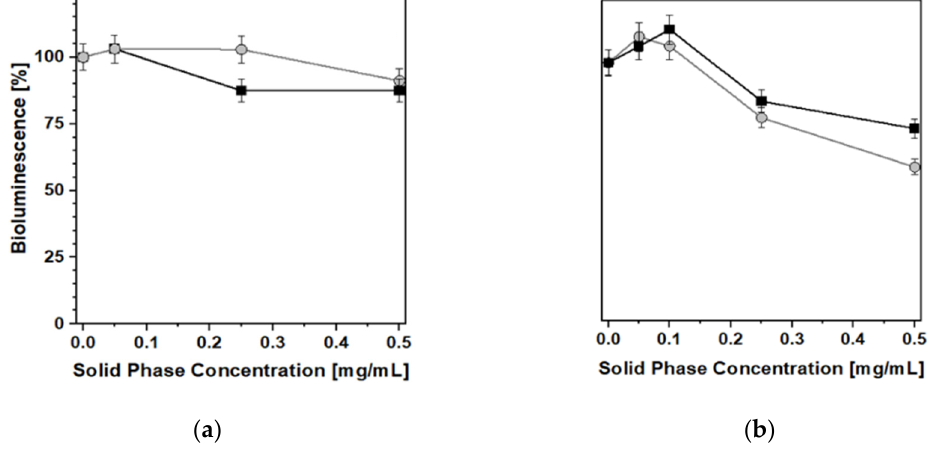
Figure 8. Acute effect of ● PB_Syn and ■ PB_Com samples on Photobacterium leiognathi Sh1 ( a ) and Figure 8. Acute e ff ect of • PB_Syn and (cid:4) PB_Com samples on Photobacterium leiognathi Sh1 ( a ) and